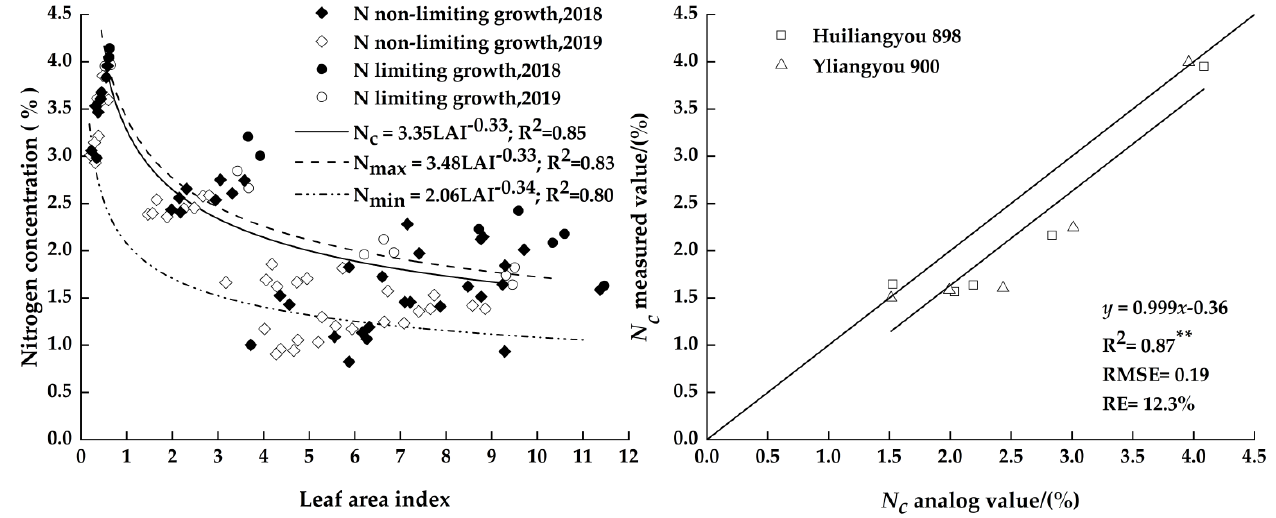
Figure 6. Validation of the established critical nitrogen dilution curves with independent data. ** indicates significance at the 0.01 level.